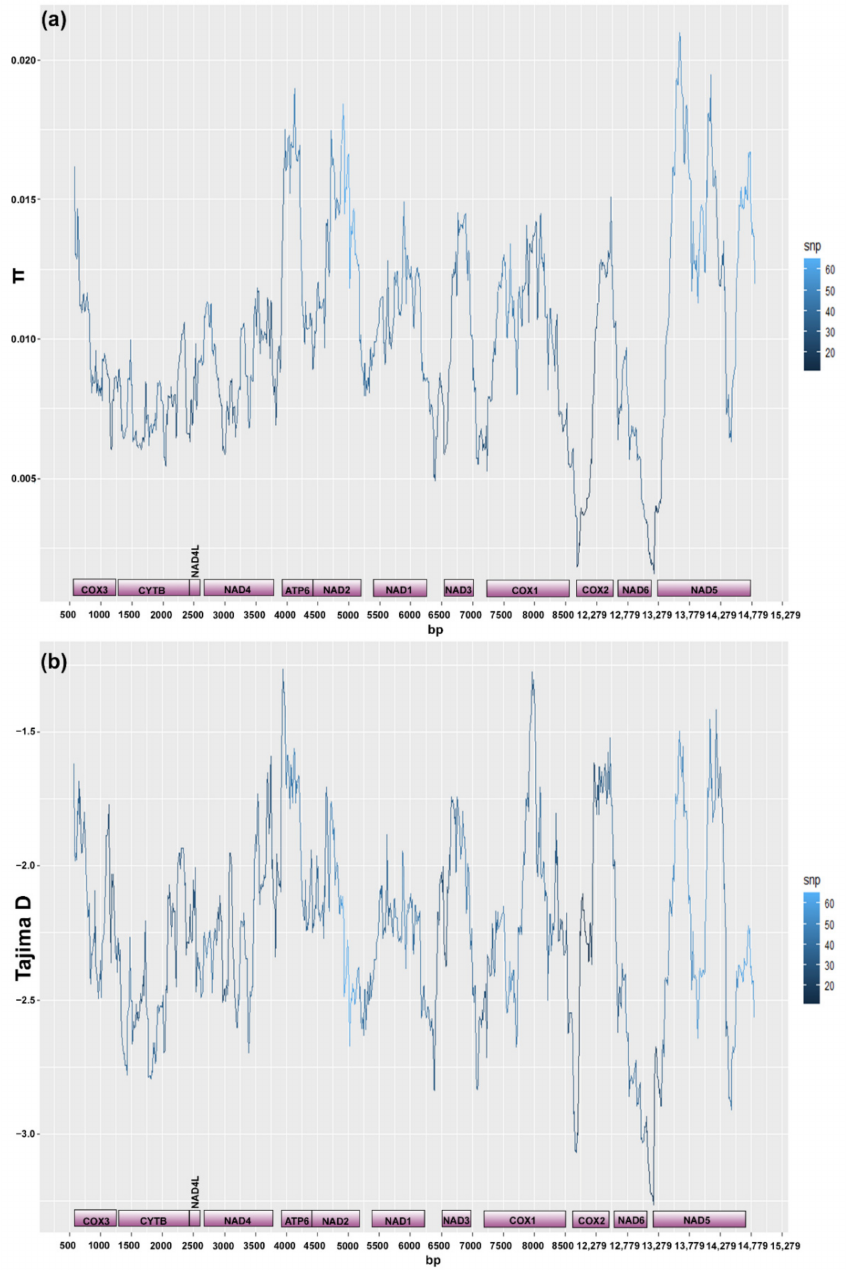
Figure 6. Sliding window analyses (window size 300 bp, step size 10 bp) of PoolSeq data to infer nucleotide diversity ( a ) and Tajima’s D parameter ( b ) across the mitogenome of Cichlidogyrus casuari- nus ex Hemibates stenosoma (excluding ribosomal and non-coding genes). Gene boundaries with the respective position in the mitogenome are below the graph. The colour scale denotes the number of SNPs in the sliding